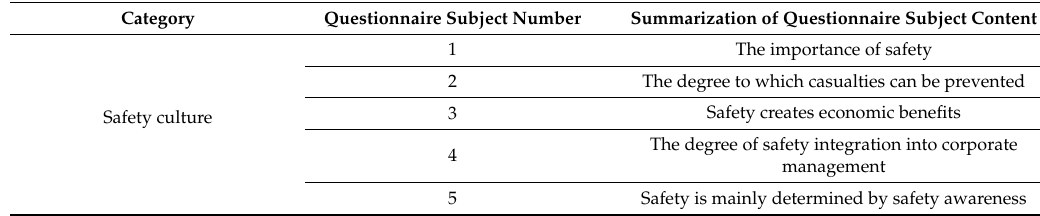
Table 1. Overview of questionnaire setting